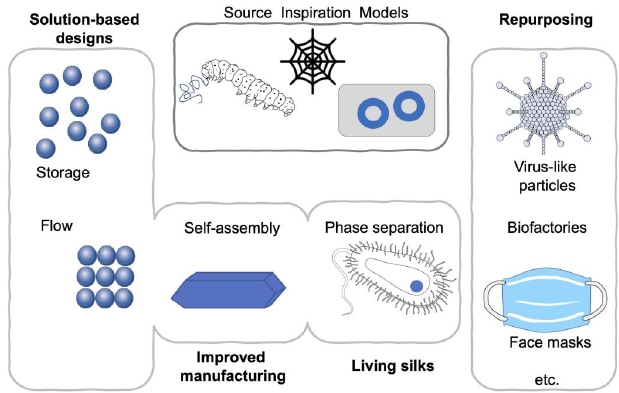
Figure 1. Summary of emerging silk material trends. Repurposing [23,25,27,28], solution-based designs [24], phase separation [30,31] and flow [22,26,29] impacting manufacturing and creating living materials.